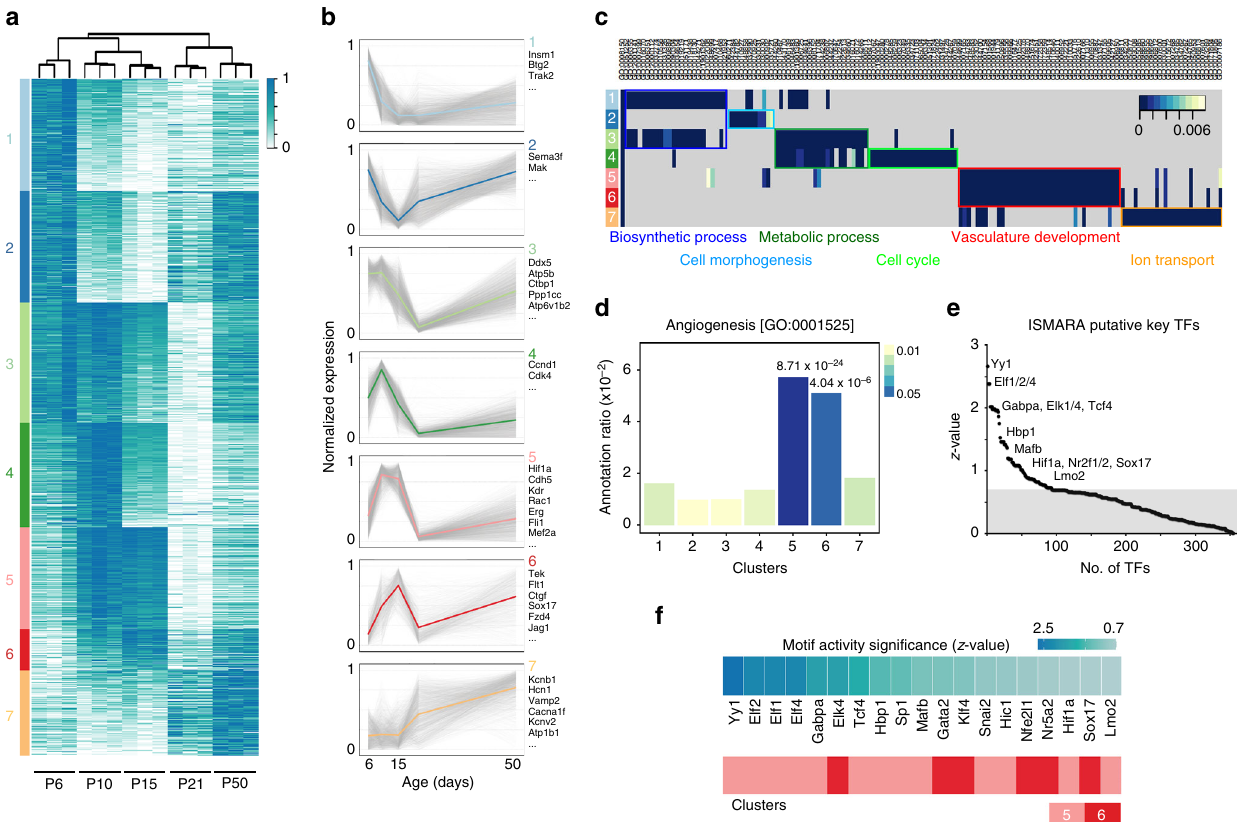
Fig. 2 Key TFs regulating EC behaviors. a , b Normalized expression dynamics of 15,364 DEGs in retinal ECs during postnatal development are shown in a heat map ( a ) and line plots ( b ). Gene names in b represent typical examples within each cluster. k -means clustering analysis identi fi ed seven clusters of DEGs according to their expression patterns. Mean expression values of each cluster are highlighted. c Gene ontology (GO) terms enrichment analysis of seven DEG clusters. The most frequent and representative terms are highlighted and boxed with same colors. d Enrichment of genes related to Angiogenesis (GO:0001525) in each cluster. e ISMARA analysis of retinal EC transcriptome during postnatal development. Graph represents the signi fi cance of TF motif activity ( z -value) with selected TFs displayed. f List of TFs with the highest (top 30%) scores of ISMARA analysis among genes belonging to the angiogenic cluster, clusters 5 and